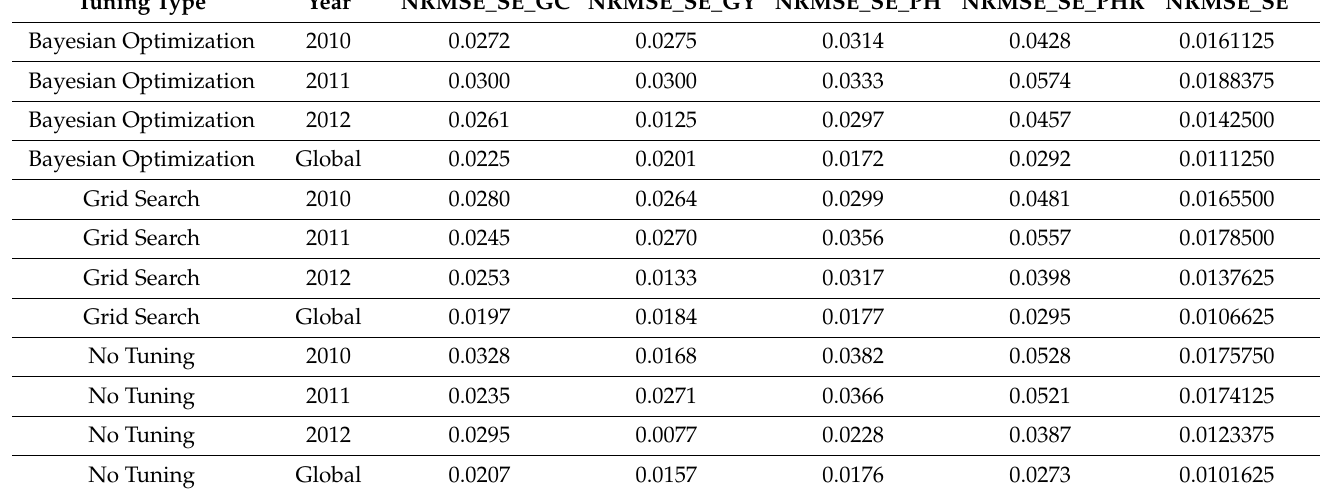
Table A5. The standard error of prediction performance for each year and across years (Global) of the dataset 2 (Indica) in terms of normalized root mean square error (NRMSE) under three methods of tuning (BO, GrS and NT). RE denotes relative efficiency.